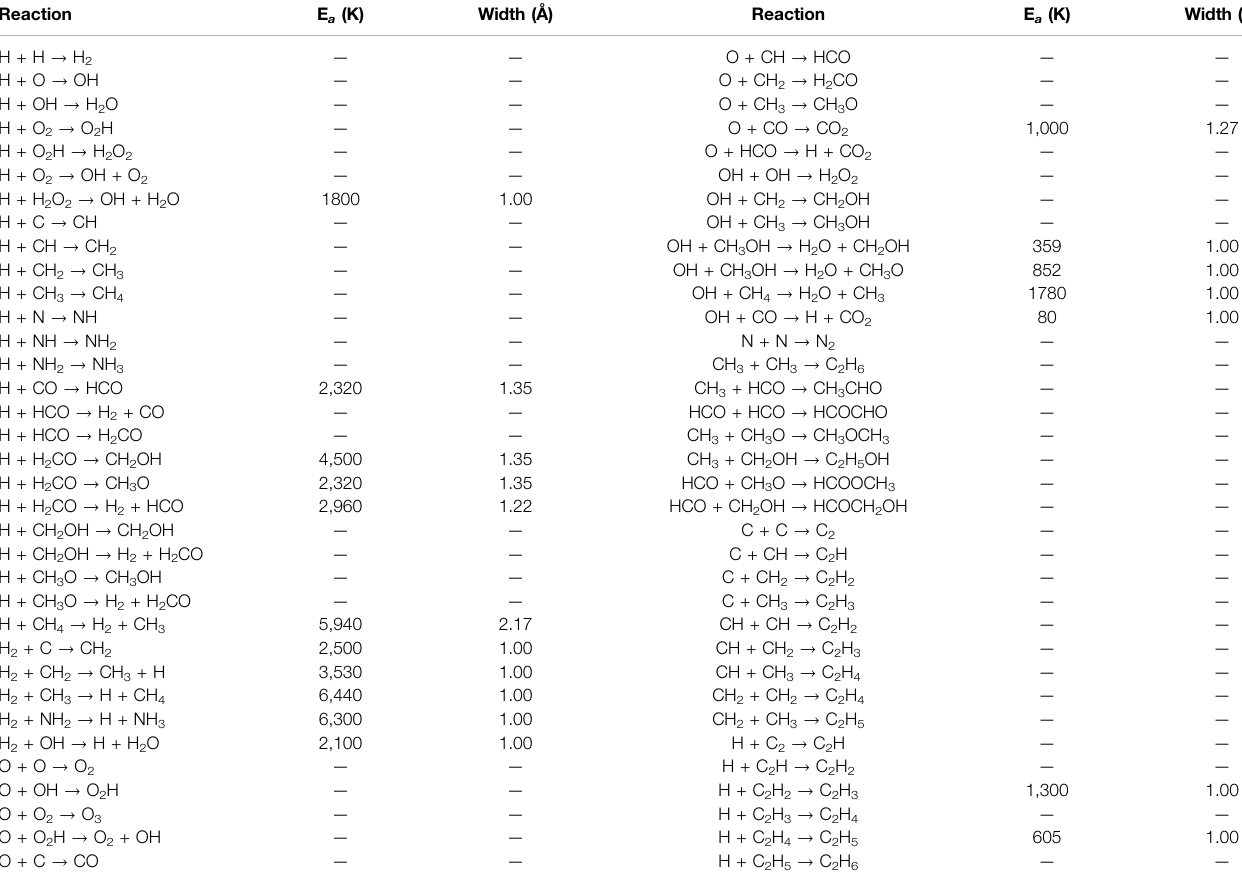
TABLE 2 | The reaction network used in MIMICK. Activation barriers, where present, are in units of Kelvin, with barrier widths in Angstrom. Reaction